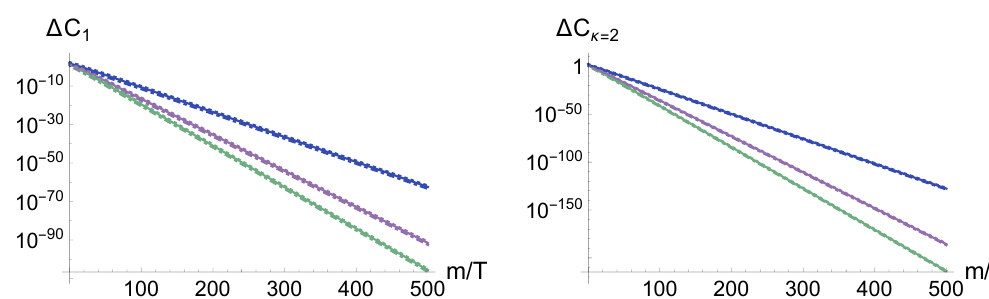
Figure 22 . Complexity of formation as a function of the mass m . Plots have been produced with L = 1 and N = 20000 . Three values of the temperature are reported, T = 1 (dotted-dashed lines), T = 10 (solid lines) and T = 50 (dotted lines), but are indistinguishable. For each T from the bottom up Ω = 0 . 1 (green), Ω = 0 . 5 (violet) and Ω = 0 . 8 (blue). The logarithmic scale shows how the complexity of formation decreases exponentially in m/T , with a coefficient fixed by Ω